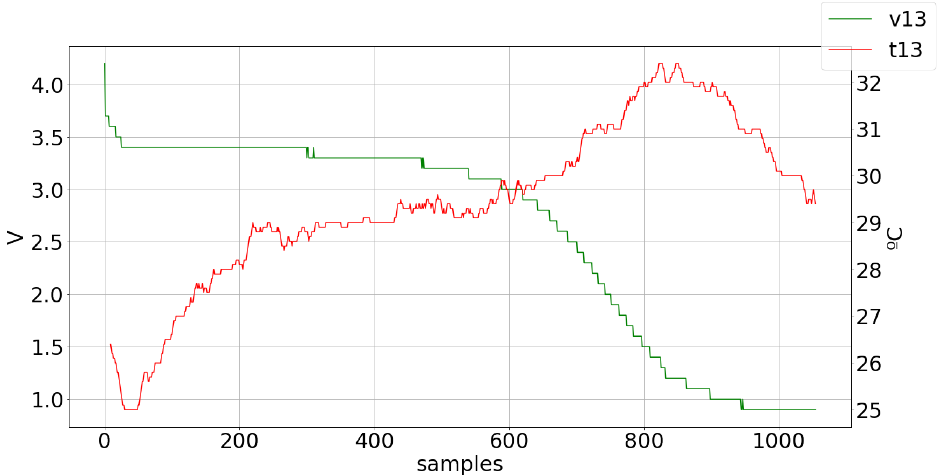
Figure 12. The temperature rises when the cell enters in the OD failures because the internal resistance increases.